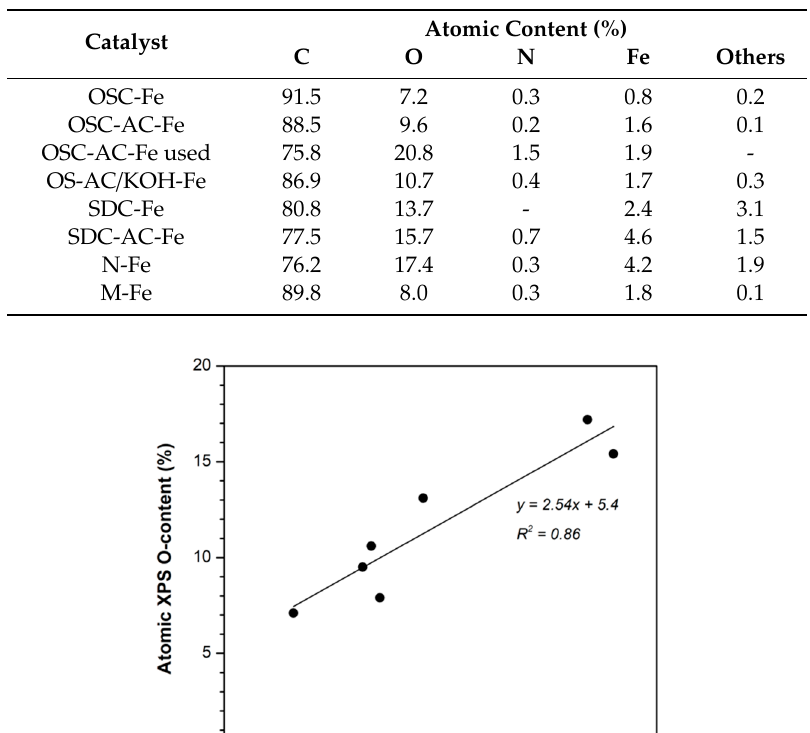
Table 4. Atomic surface composition determined by X-ray photoelectron spectroscopy (XPS) analysis of the prepared catalysts.